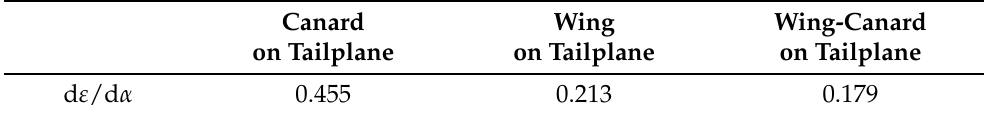
Table 7. Comparison of downwash gradient